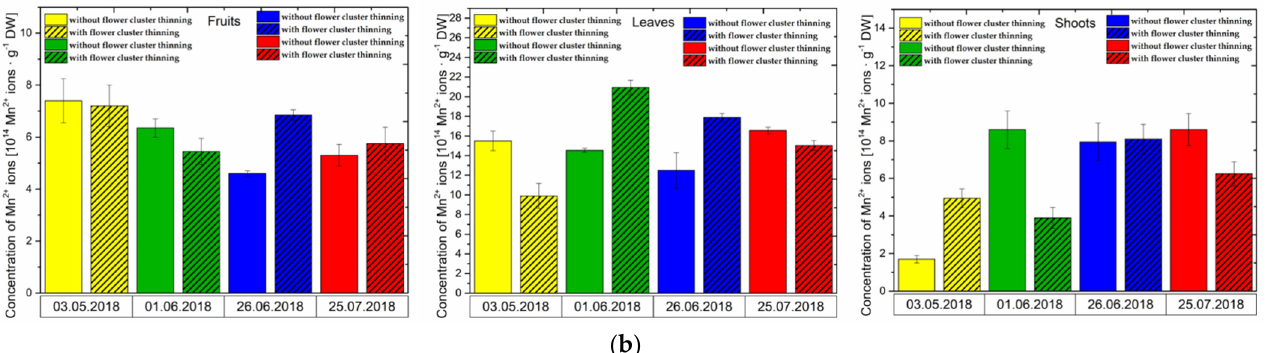
Figure 3. Concentration of Semiquinone Radicals ( a ) and Mn 2+ ( b ) in Organs of Pistachio Trees ( P. vera cv. Kirmizi) With or Without Flower Cluster Thinning Application.